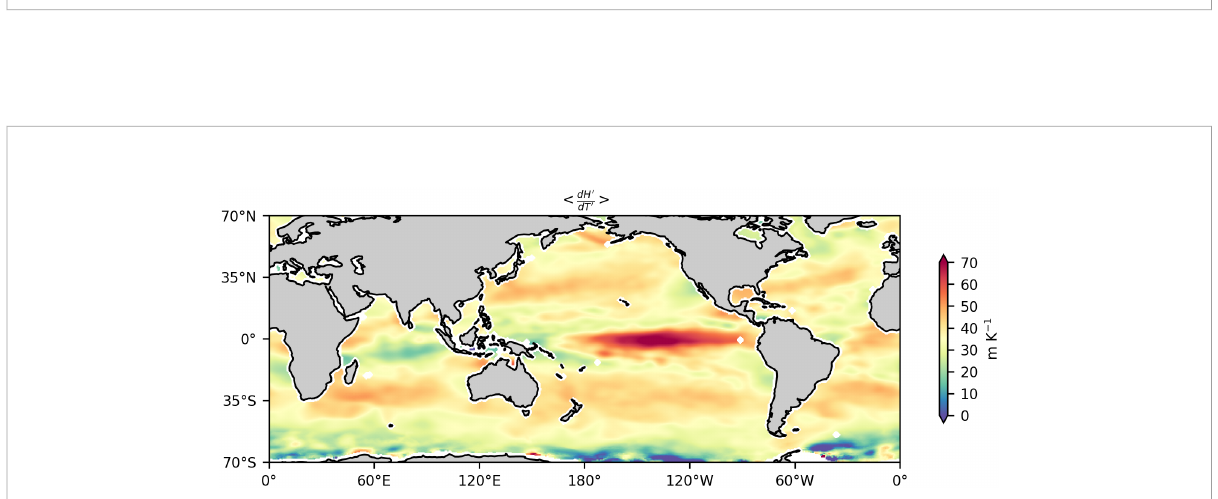
FIGURE 8 Time-mean regression coef fi cient of mesoscale MABL height ( H ) anomaly onto SSTA in the global ocean. MABL, marine atmospheric boundary layer; SSTA, sea surface temperature anomaly.